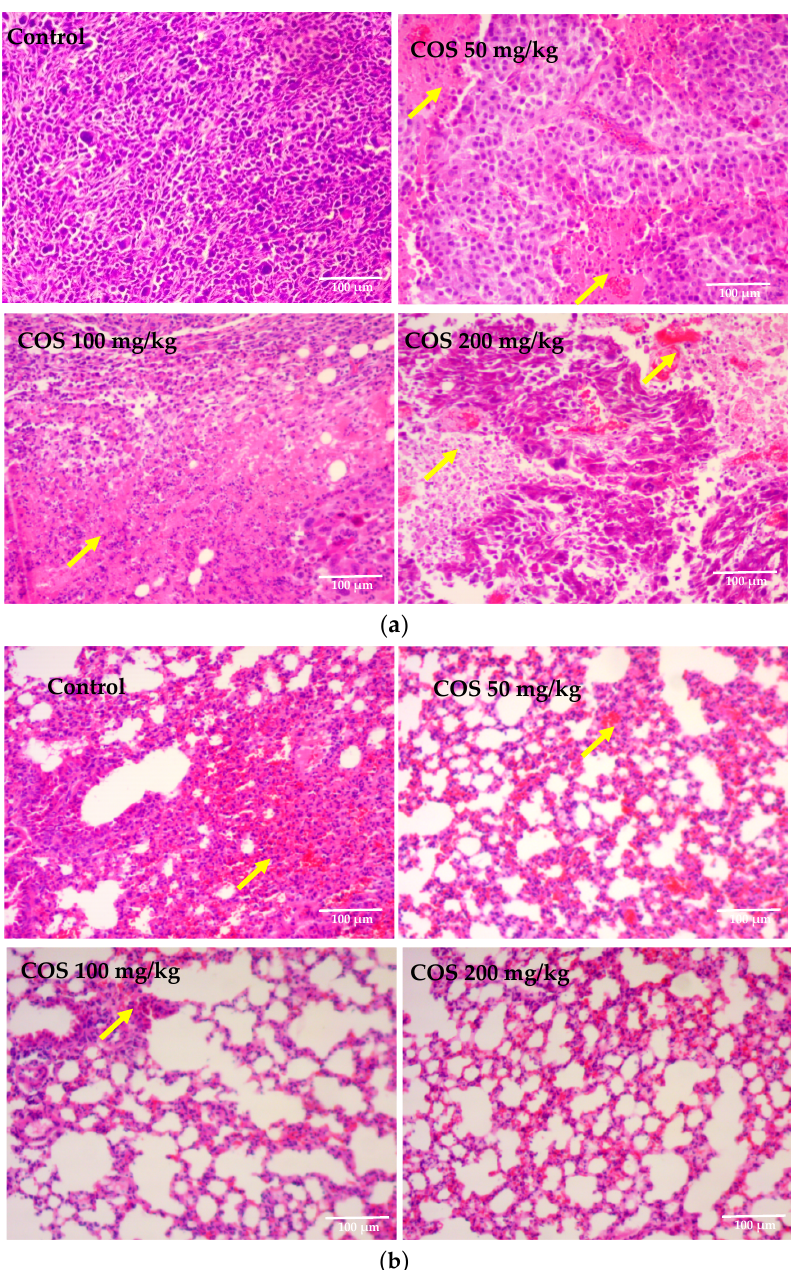
Figure 5. Effect of COS on the histopathology of Lewis tumor and lung tissues (original magnification, 100 × ). ( a ) Pathological section of tumor; ( b ) Pathological section of lung tissues. Arrow: apoptosis cells .